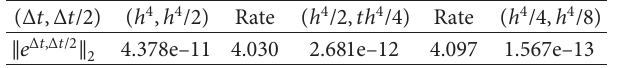
Table 1: Rate of convergence of RK4.